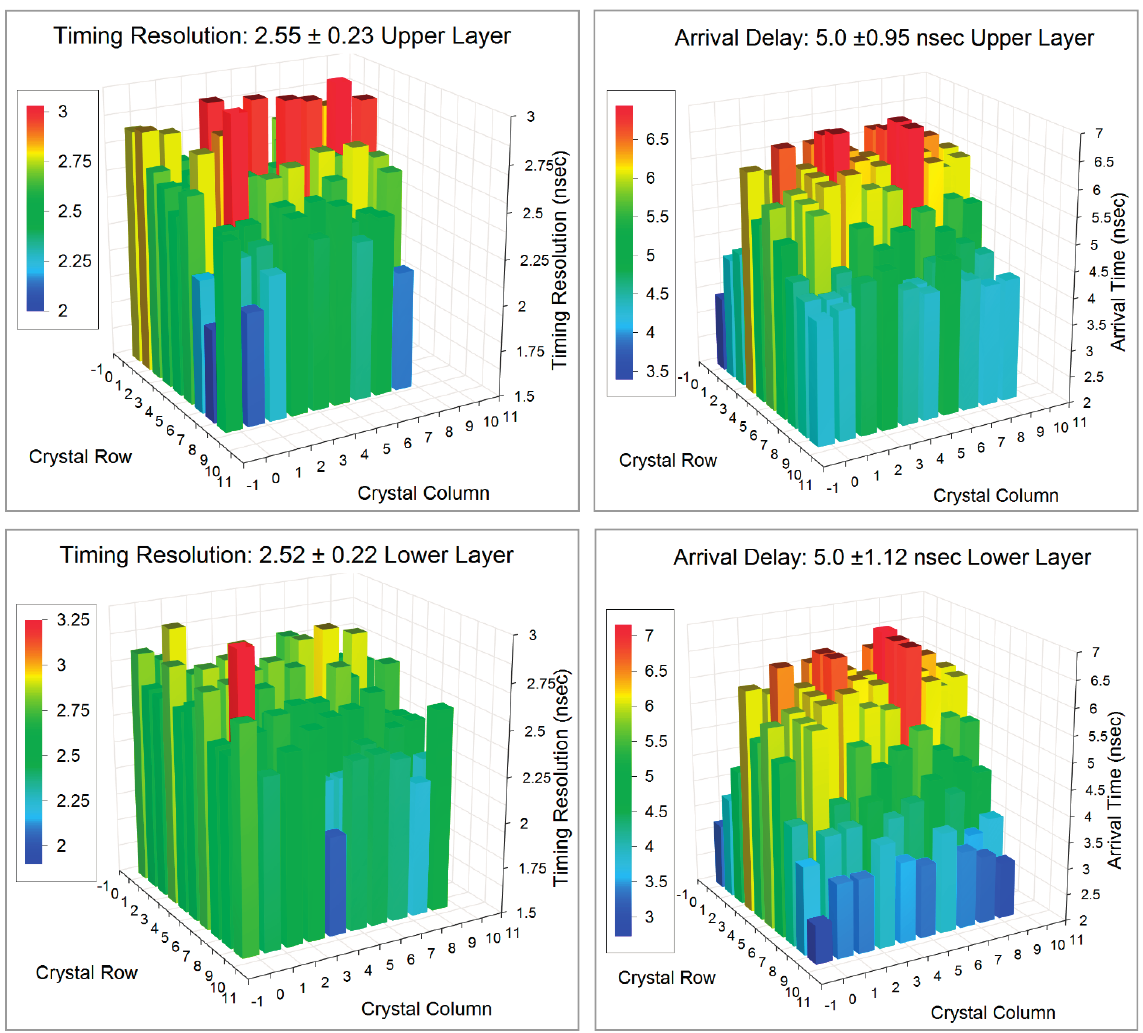
Figure 11. The timing resolution and arrival time delays for the dual layer block plotted as a function of crystal location in the